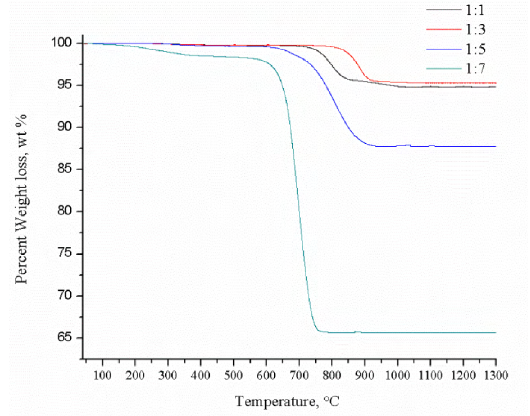
Figure 8. TGA analysis of SiCNTs synthesized from blend of SiO and MWCNTs in the ratio of 1:1; 1:3; 1:5 and 1:7. It can be observed that SiCNTs synthesized from the blend of SiO and MWCNTs in the ratio of 1:1 has shown 2 weight loss of 5% and started at 700 °C. It is believed that this weight loss of 5% was due to the decomposition of the with XRD pattern of SiCNTs in Figure 3 (a) in which